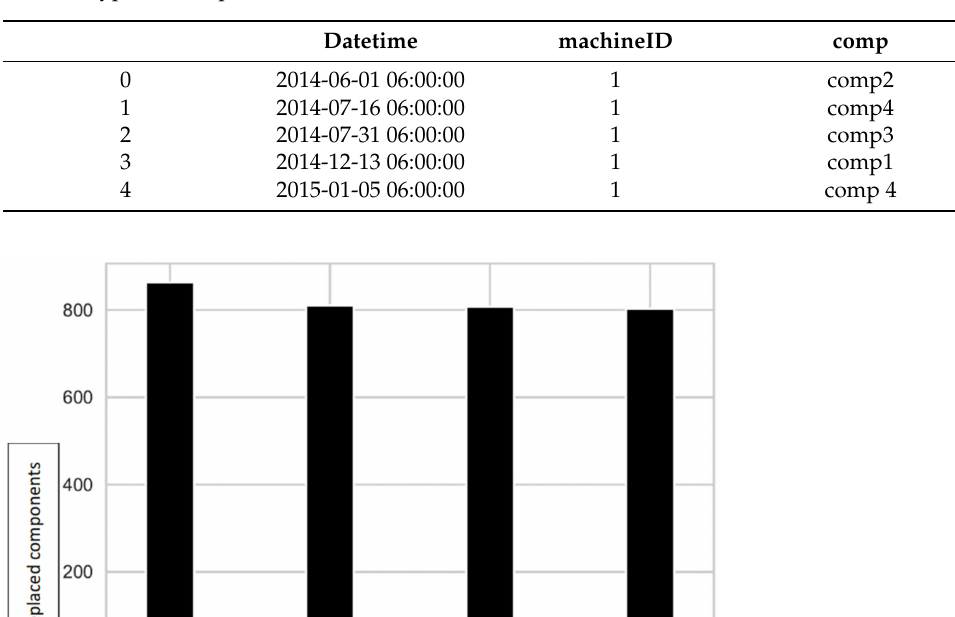
Figure 3. Representation of the number of errors by type. Table 4. Typical example of maintenance records.